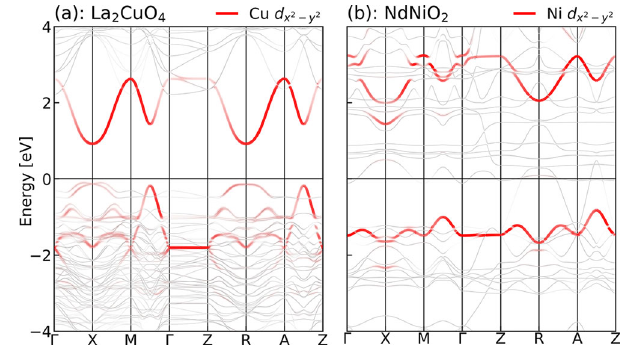
Fig. 8 Comparison the 3 d x 2 (cid:1) y 2 band between G -type antiferromagnetic ( G -AFM) phase of La 2 CuO 4 and C -type antiferromagnetic ( C -AFM) of NdNiO 2 . a Cu 3 d x 2 (cid:1) y 2 band for G -AFM La 2 CuO 4 . b Ni 3 d x 2 (cid:1) y 2 band for C - AFM NdNiO 2 . Band structures have been unfolded into the 1 × 1 × 1 primitive Brillouin zone.